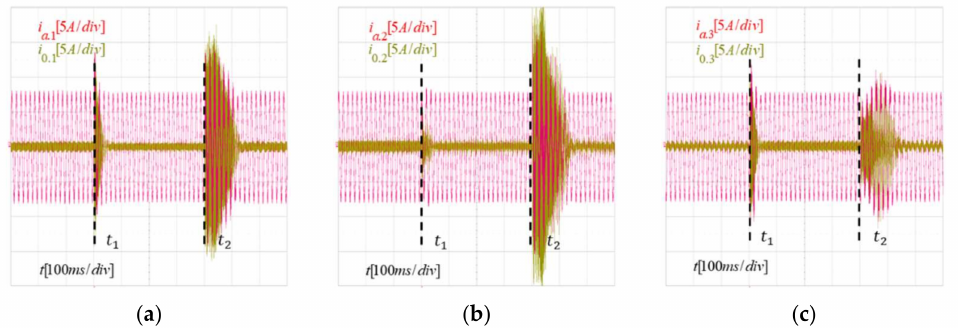
Figure 14. Results of experiment of phase error control during normal operation ( a ) phase a output current and zero − sequence current of inverter 1, ( b ) phase a output current and zero − sequence current of inverter 2, ( c ) phase a output current and zero − sequence current of inverter